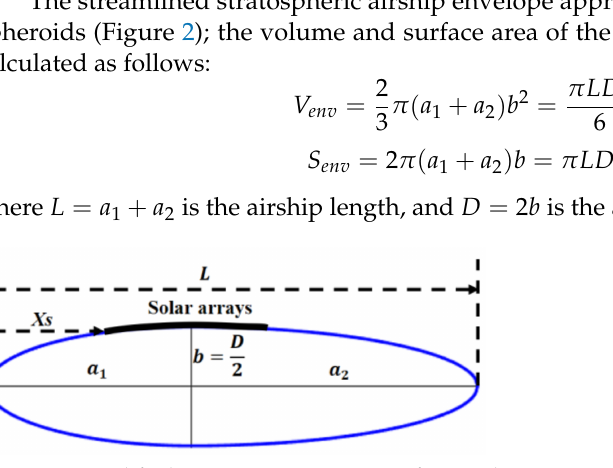
Figure 2. Simplified geometric parameters of an